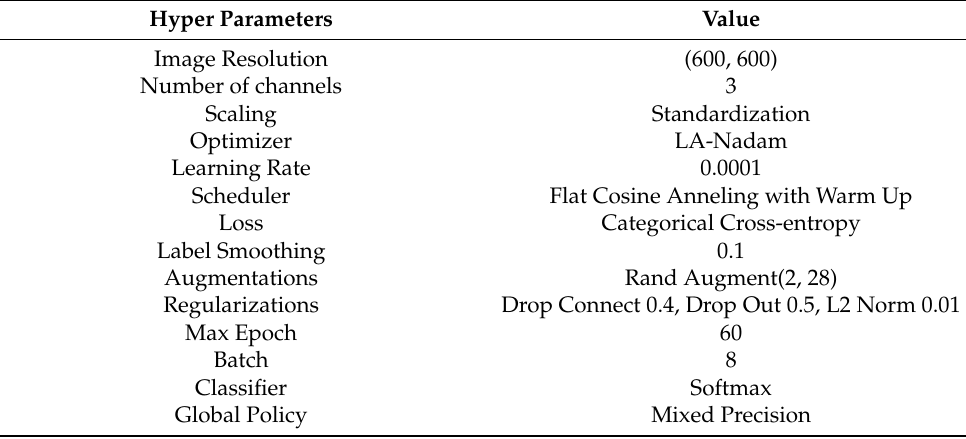
Table 10. Hyper Parameters.